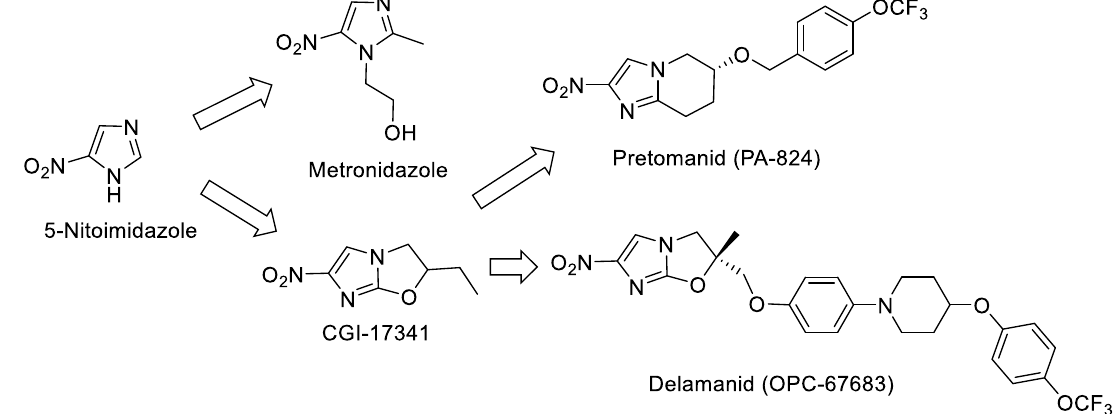
Figure 1. The progression of 5-Nitoimidazole derivatives .